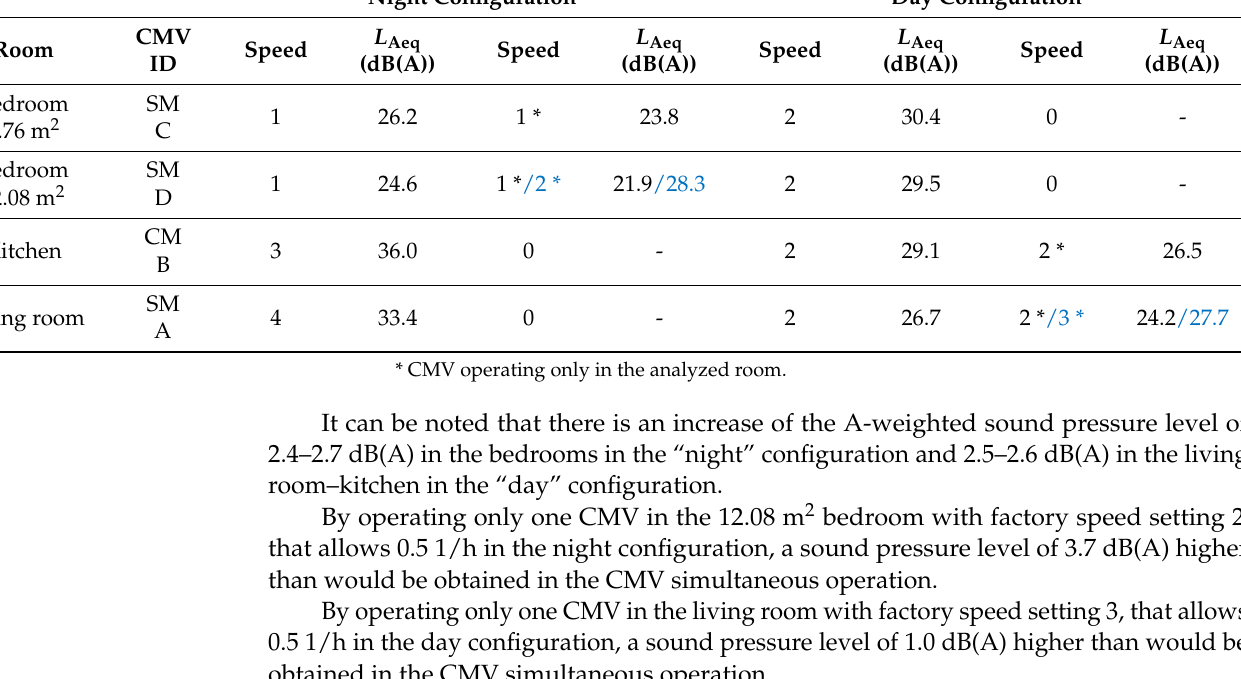
Table 10. Three-room apartment. Night and day configurations (in blue 0.5 1/h single operation CMV speed). Night Configuration